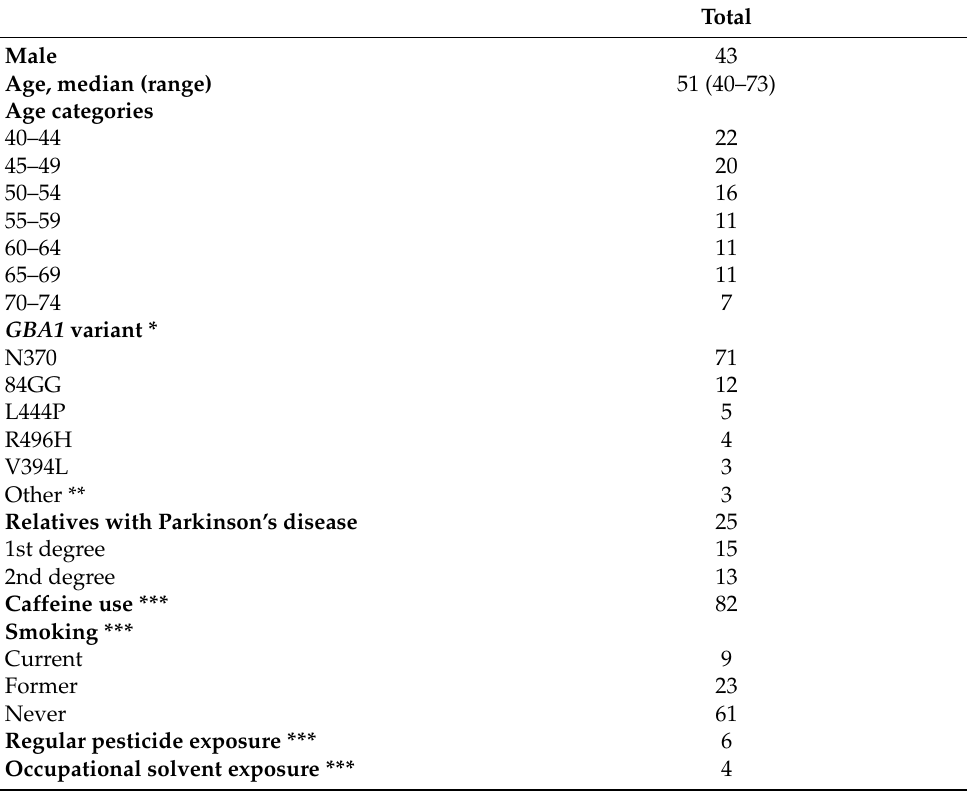
Table 1. Characteristics of the 98 GBA carriers enrolled in the study.